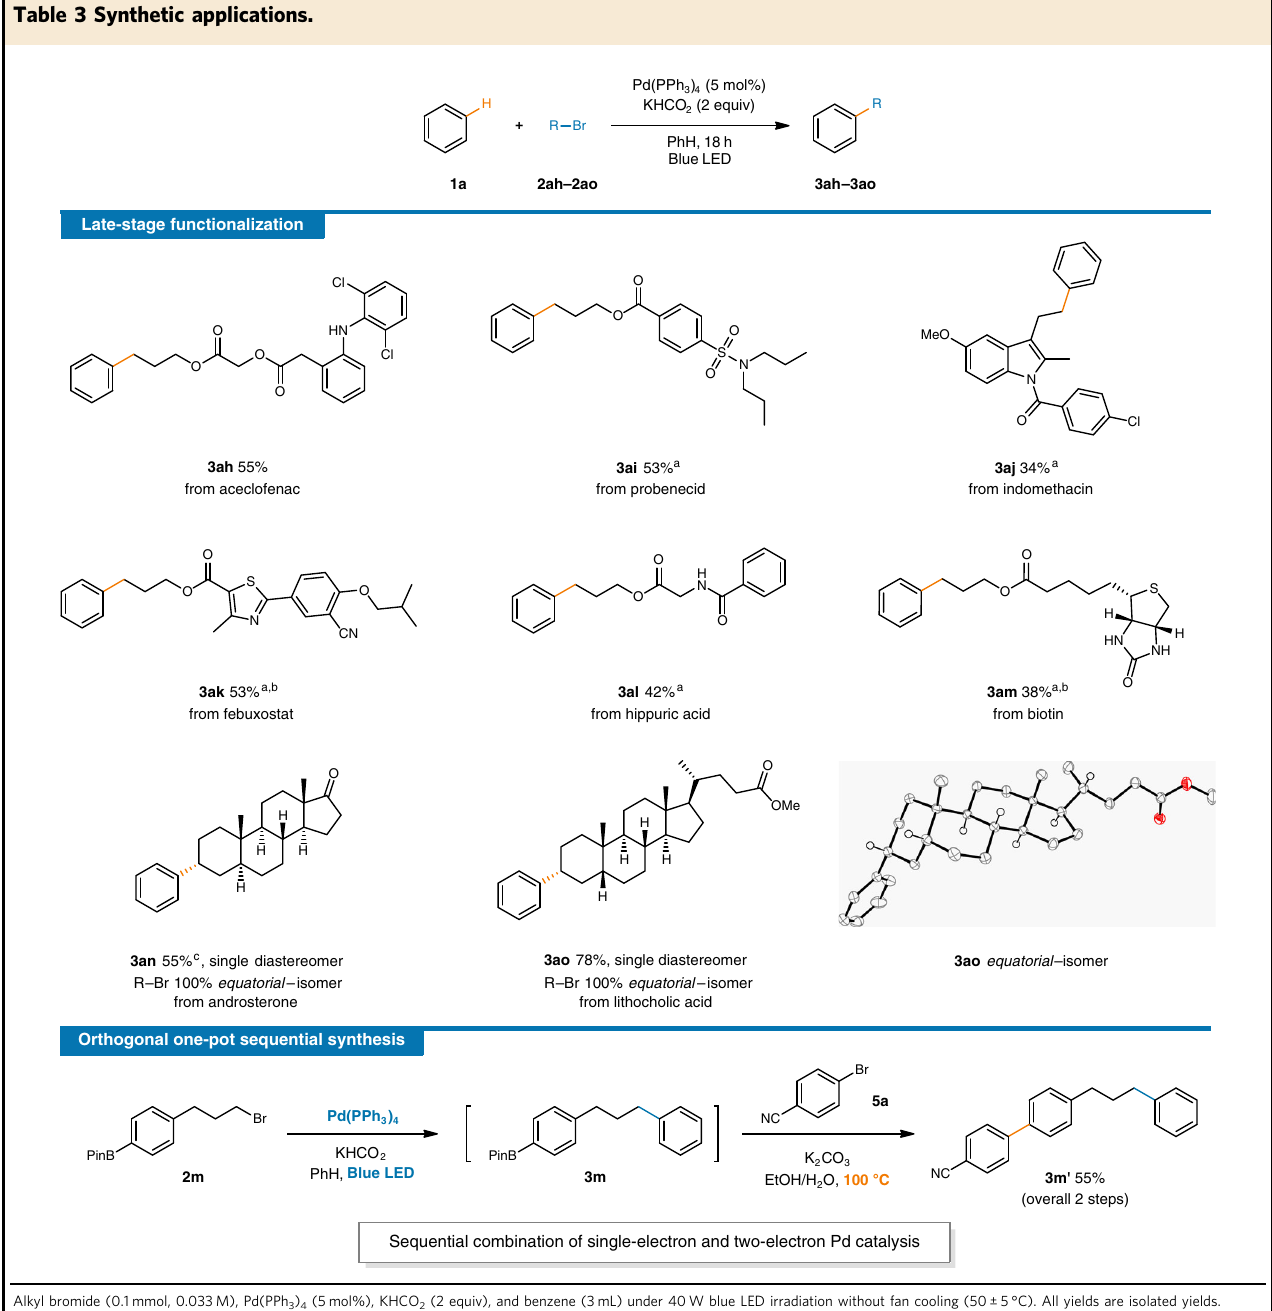
Table 3 Synthetic applications.